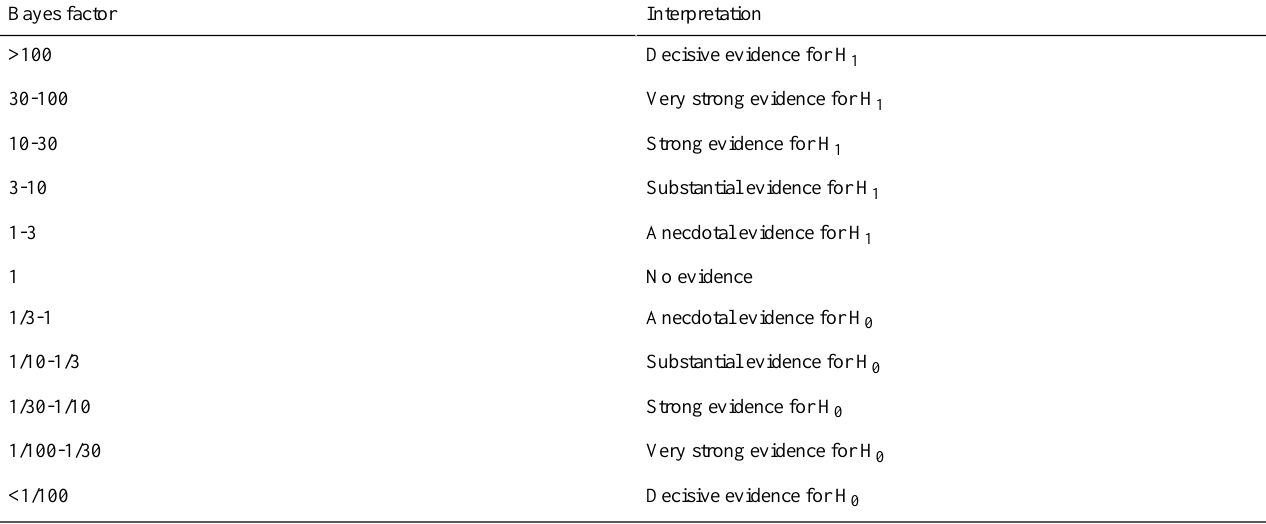
InterpretationBayes